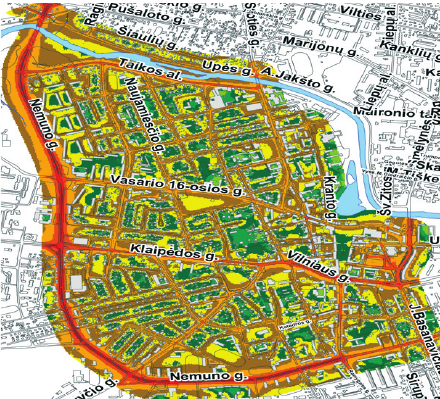
Fig. 6. Modelled noise level of segment 1 of the central part of Panevėžys city by night